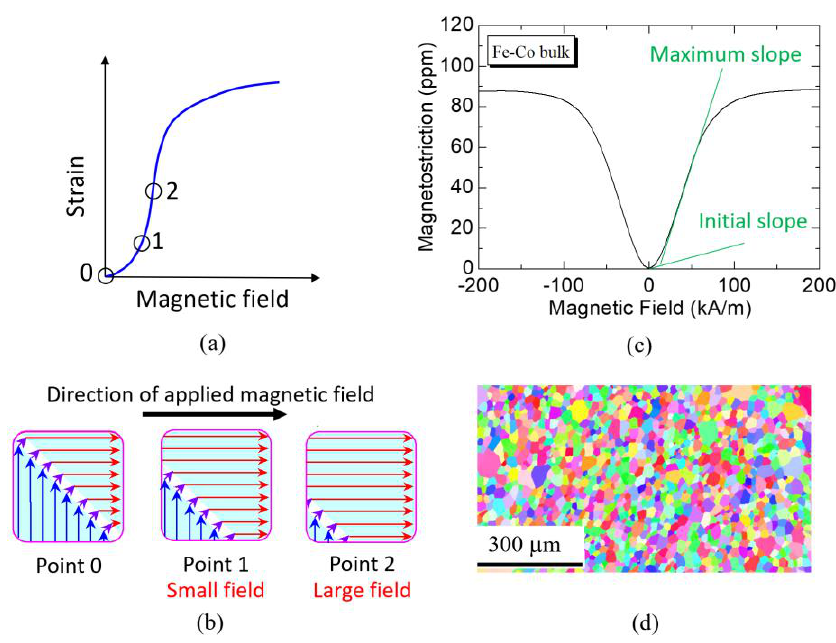
Figure 8. Magnetostriction of the Fe-Co bulk: ( a , b ) initial changes and domain movement in the magnetostrictive material, ( c ) magnetostriction curve of the Fe-Co bulk and ( d ) inverse pole figure (IPF) map of the Fe-Co bulk.